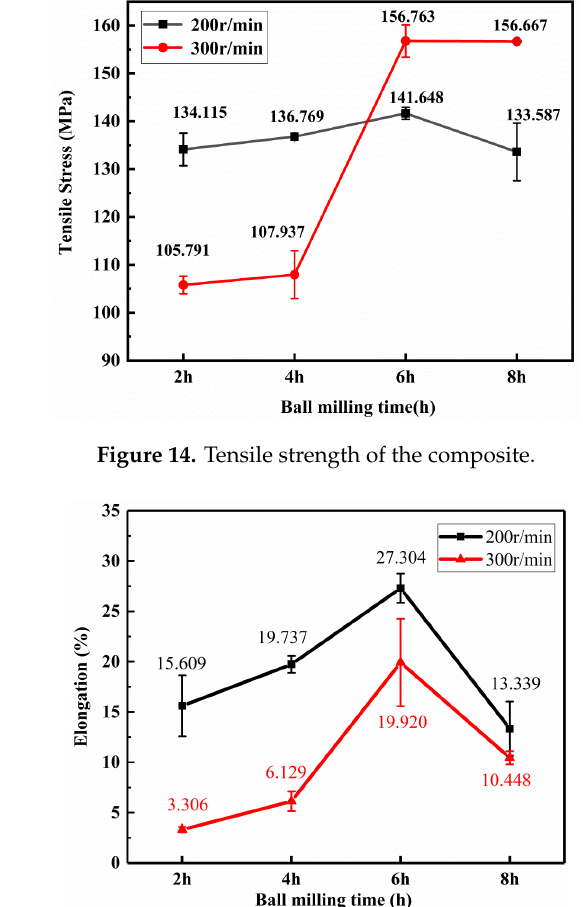
Figure 13. Tensile strength of the hot-pressed composite. ( a ) 200 r/min; ( b ) 300 r/min.